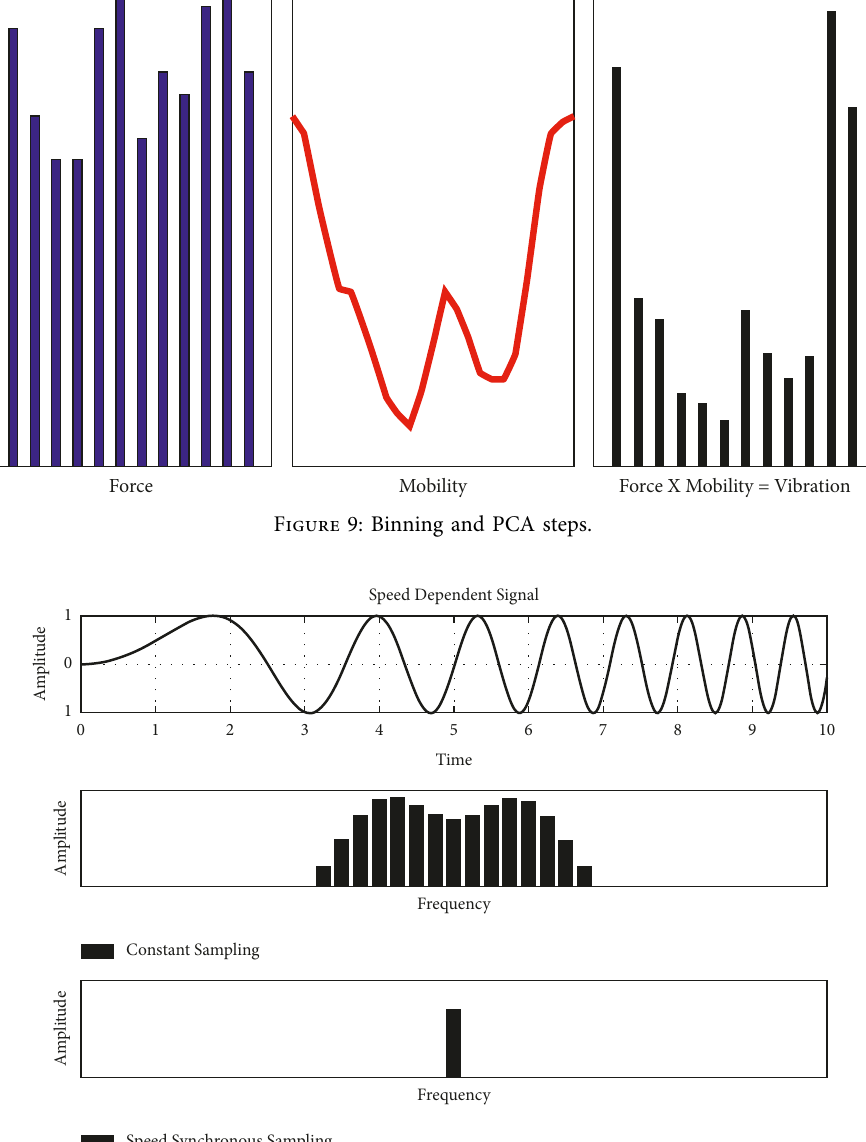
Figure 10: Force and transfer